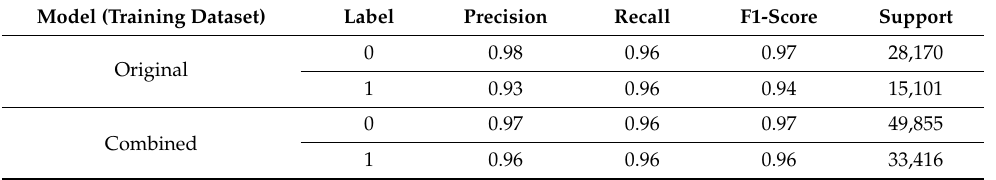
Table 5. Training metrics for both training processes of the NN classifier.